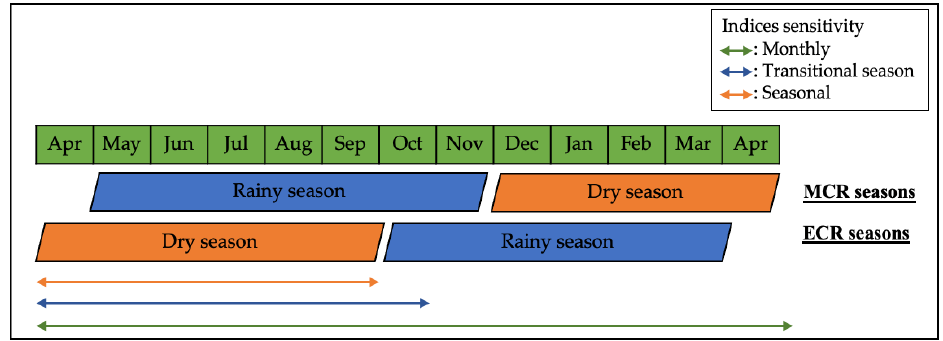
Figure 5. Timing of index sensitivity. The dry season occurs from April to October in the equatorial climate region (ECR) and December to April in the monsoon climate region (MCR). The green, blue, and orange arrows show the monthly, seasonal, and transitional sensitivity of detection of drought, respectively.